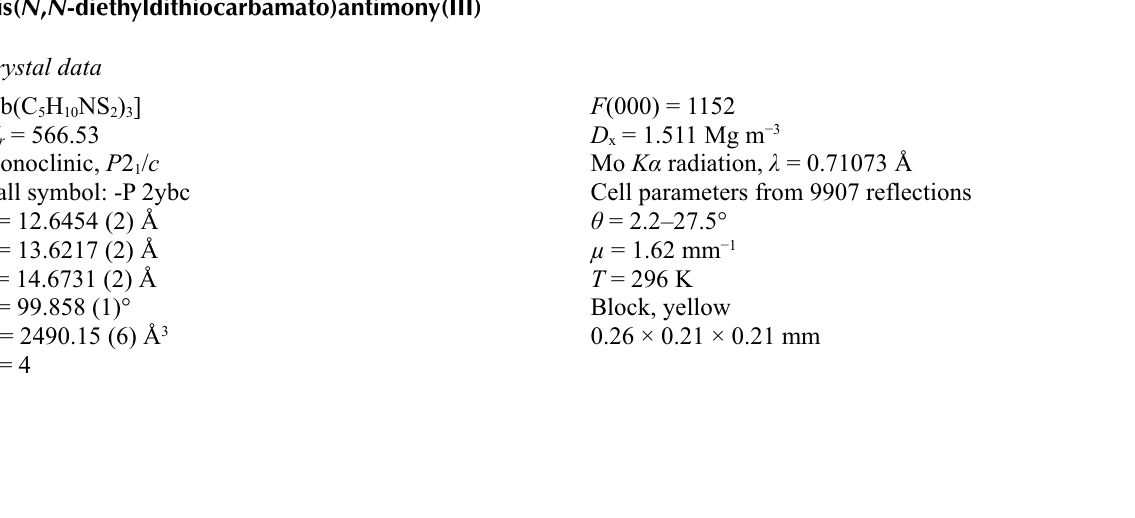
The structure of (I), showing 30% probability displacement ellipsoids and the atom-numbering scheme. tris( N , N